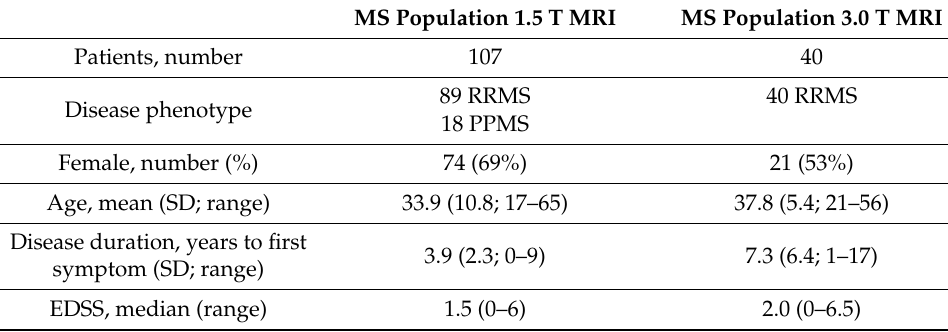
Table 1. Demographic and clinical characteristics of populations at the time of